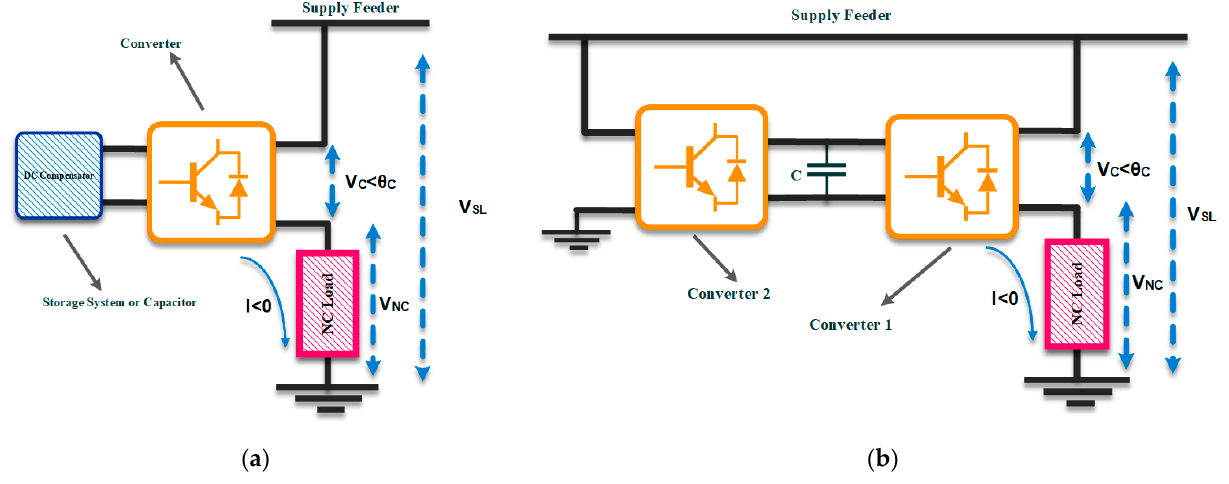
Figure 7. SL’s different configurations [78]: ( a ) SLQ or SLES; ( b ) SLBC.